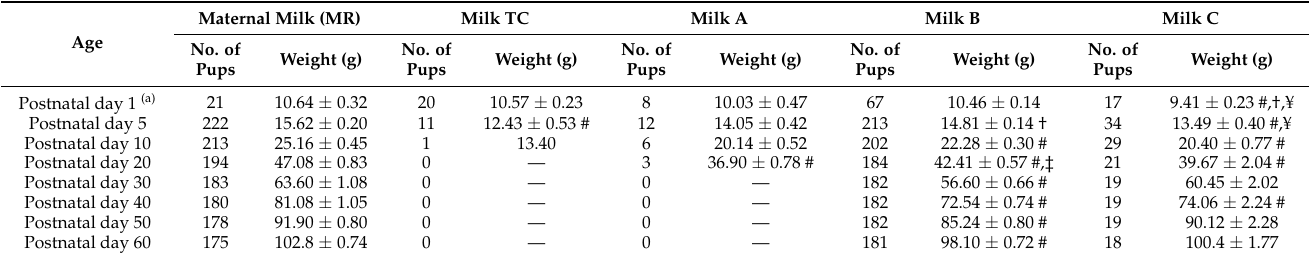
Table 2. Body weight of the Chinese tree shrew pups fed with different milks.